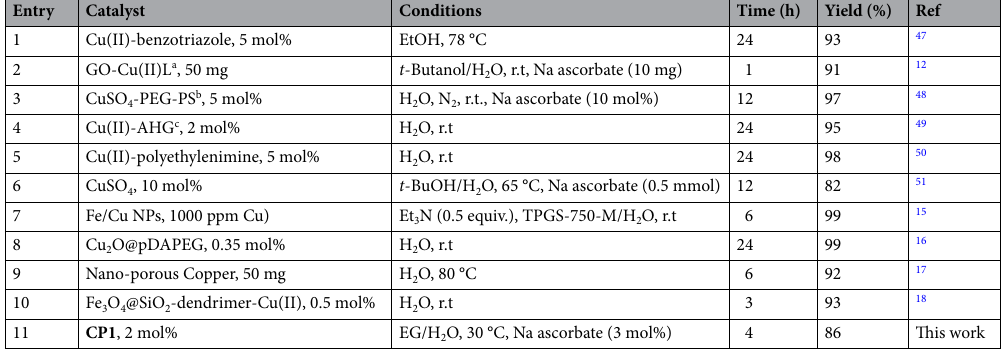
Table 5. Comparison of CP1 catalytic protocols with other catalytic system in the synthesis of 1,4-disubstituted 1,2,3-triazoles. a Cu(II)L: Copper(II) Bis (2,20-bipyridine). b PEG-PS: poly(ethylene glycol)- polystyrene. c Cu(II)-alginate hydrogel, pDAPEG: polydiacetylene micelles-polyethyleneglycol.